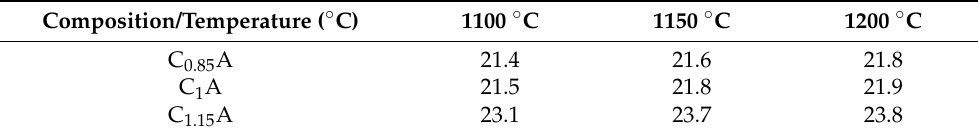
Table 1. Weight reductions (wt.%) at different applied sintering